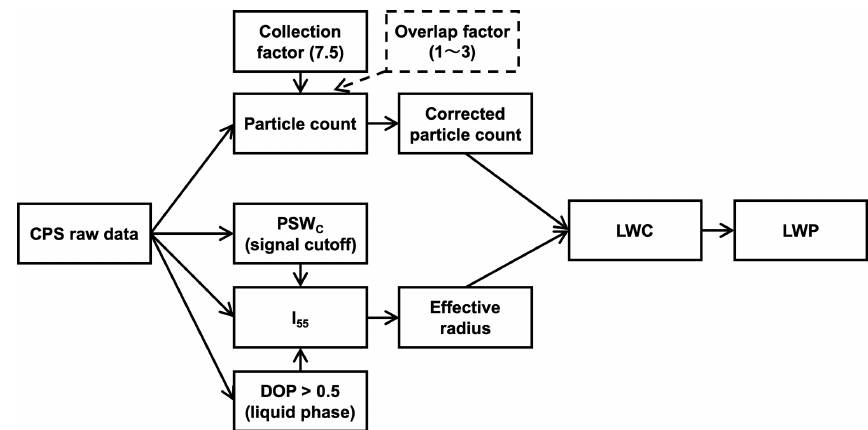
Figure 13. Flow chart for calculating LWP from the raw CPS